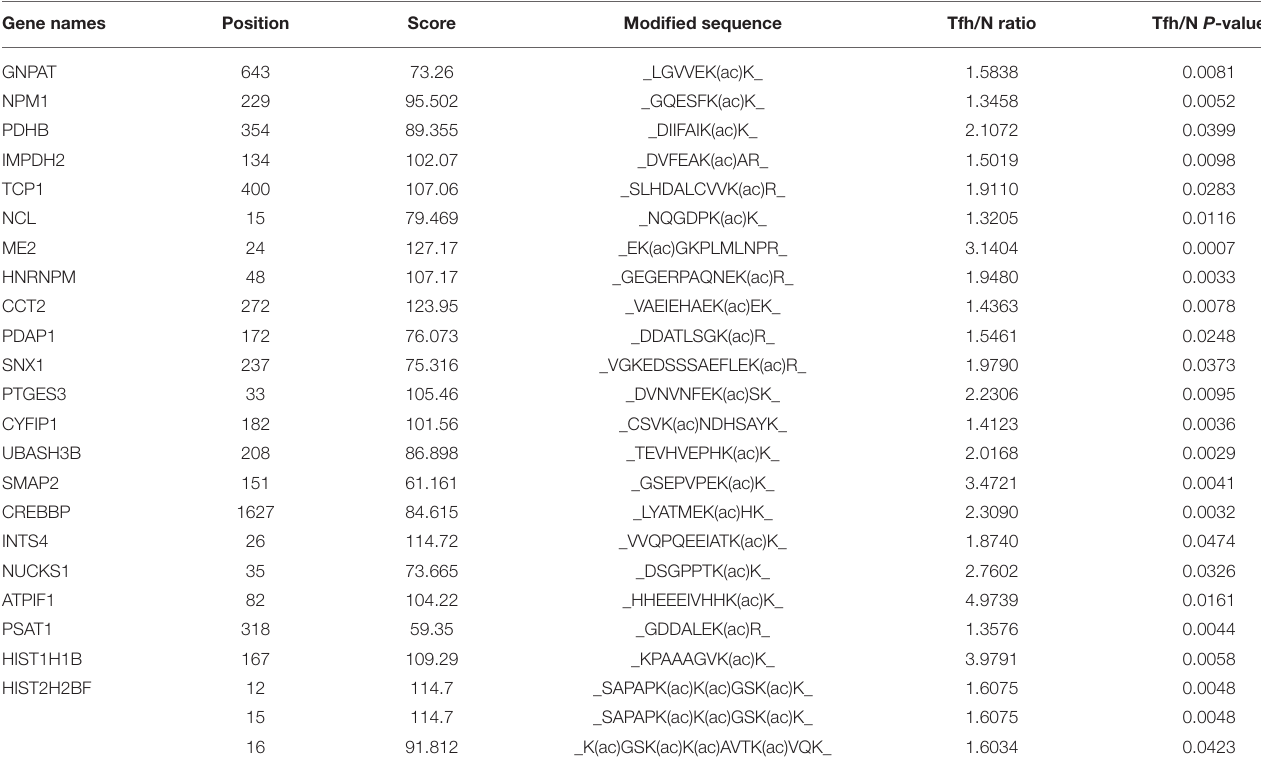
TABLE 1 | The information of 24 upregulated lysine (K) acetylated residues corresponding to 22 proteins in iTfh cells compared to the naive CD4 + T cells was